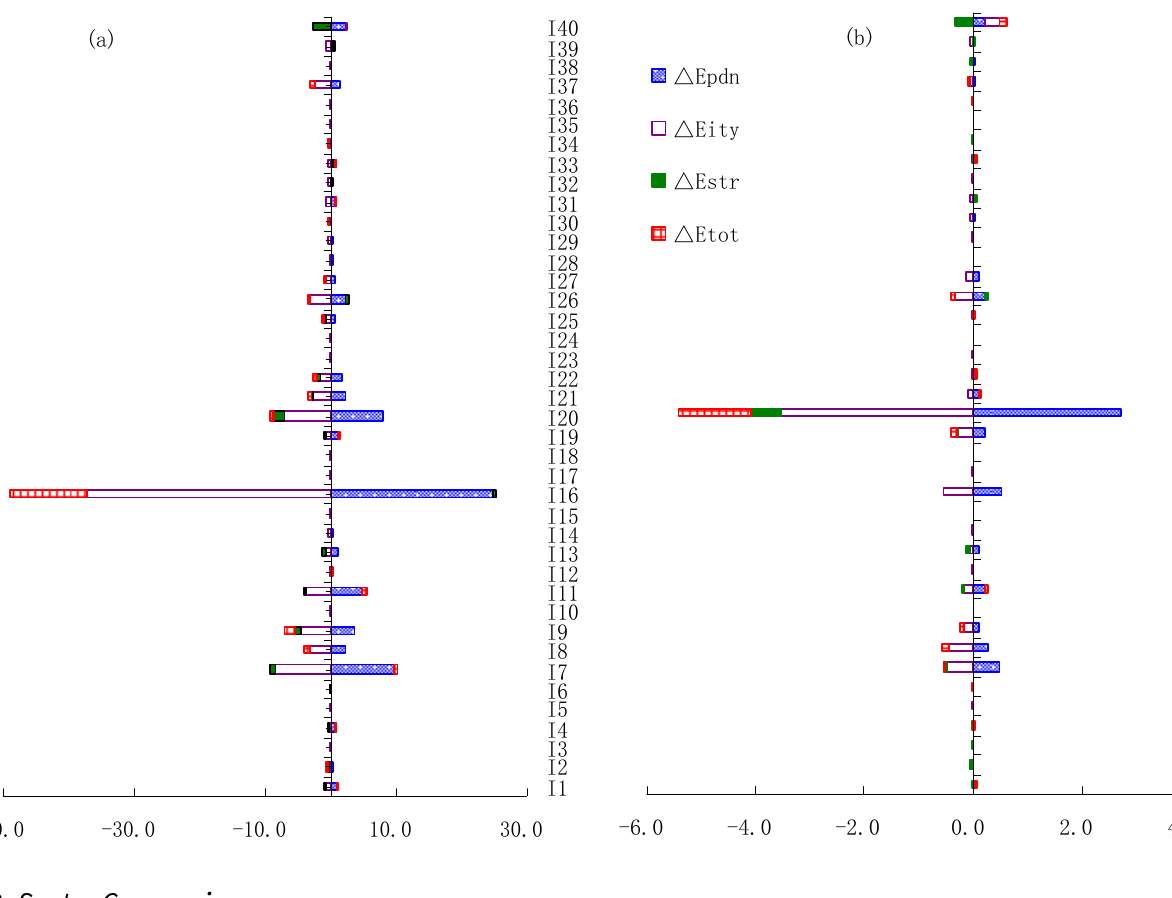
Figure 3. The average changes of industrial pollutant discharges for all sub-sectors between 2001 and 2009 ( a ) COD; ( b ) NH 4